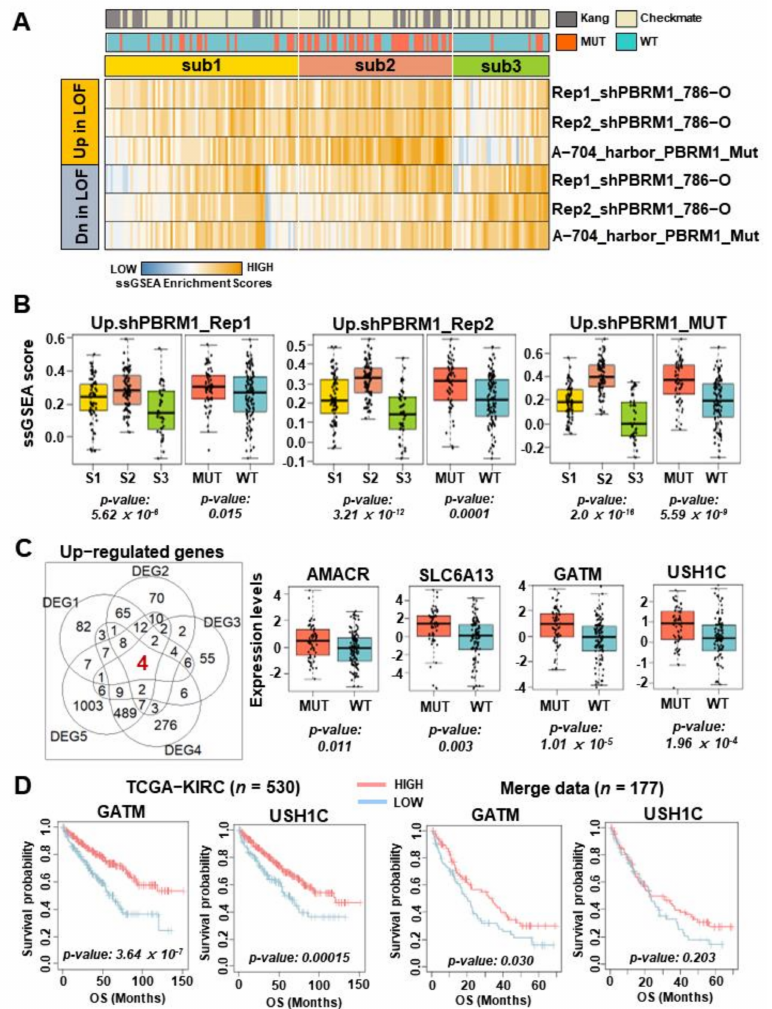
Figure 4. GATM expression is related to PBRM1 mutation and PBRM1 loss of function. ( A ) Heatmap of enrichment scores for the single-sample gene set enrichment analysis using upregulated and down- regulated differentially expressed genes (DEGs) derived from cell line data GSE102806. ( B ) Boxplots summarizing the heatmap in ( A ) for each subtype (left) and in the group with PBRM1 mutation vs. the group without PBRM1 mutation (right) (S1, Sub1; S2, Sub2; S3, Sub3). ( C ) Venn diagram shows the overlapping of the five upregulated DEGs (left). Boxplots show the expression levels of AMACR , SLC6A13 , GATM , and USH1C according to patients with and without PBRM1 mutation in the merged data (right). ( D ) Kaplan–Meier plots show the overall survival of the patients stratified according the above or below the average GATM or USH1C in TCGA-KIRC ( n = 530) and the merged data ( n = 177). High expression (pink), low expression (sky